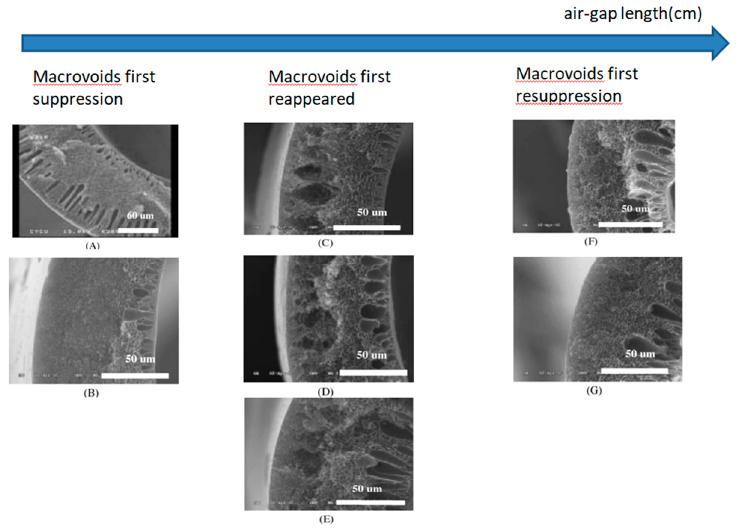
Figure 7. Membrane cross-section morphology of PS hollow fibers prepared with an ambient relative humidity of 30% for different air gap length (cm): ( A ) 0 cm, ( B ) 10 cm, ( C ) 20 cm, ( D ) 30 cm, ( E ) 40 cm, ( F ) 50 cm and ( G ) 60 cm, adapted from [191] .